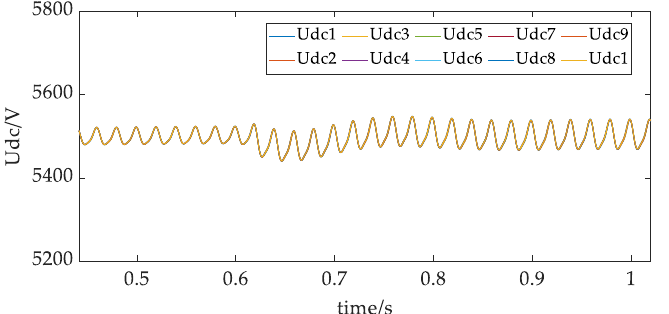
Figure 23. Capacitor voltage of sub-module in one bridge arm.